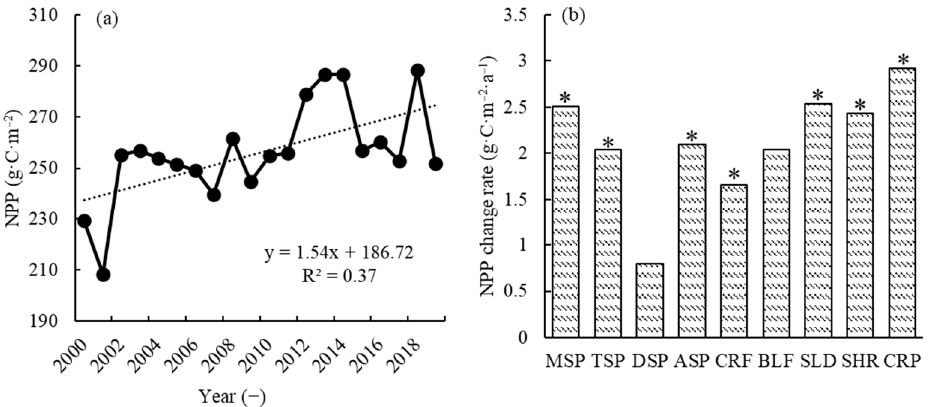
Figure 5. The temporal variations of the MP’s NPP ( a ) for different vegetation ( b ) from 2000 to 2019 during the growing seasons (The * mark on the graph represents p < 0.05).